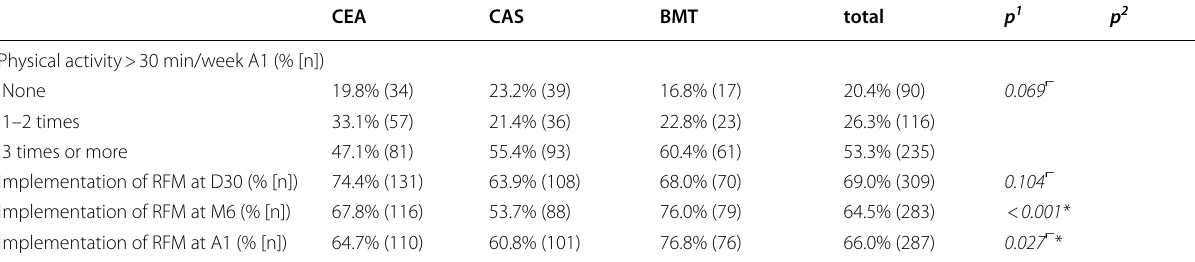
tional file 1: Table S3.